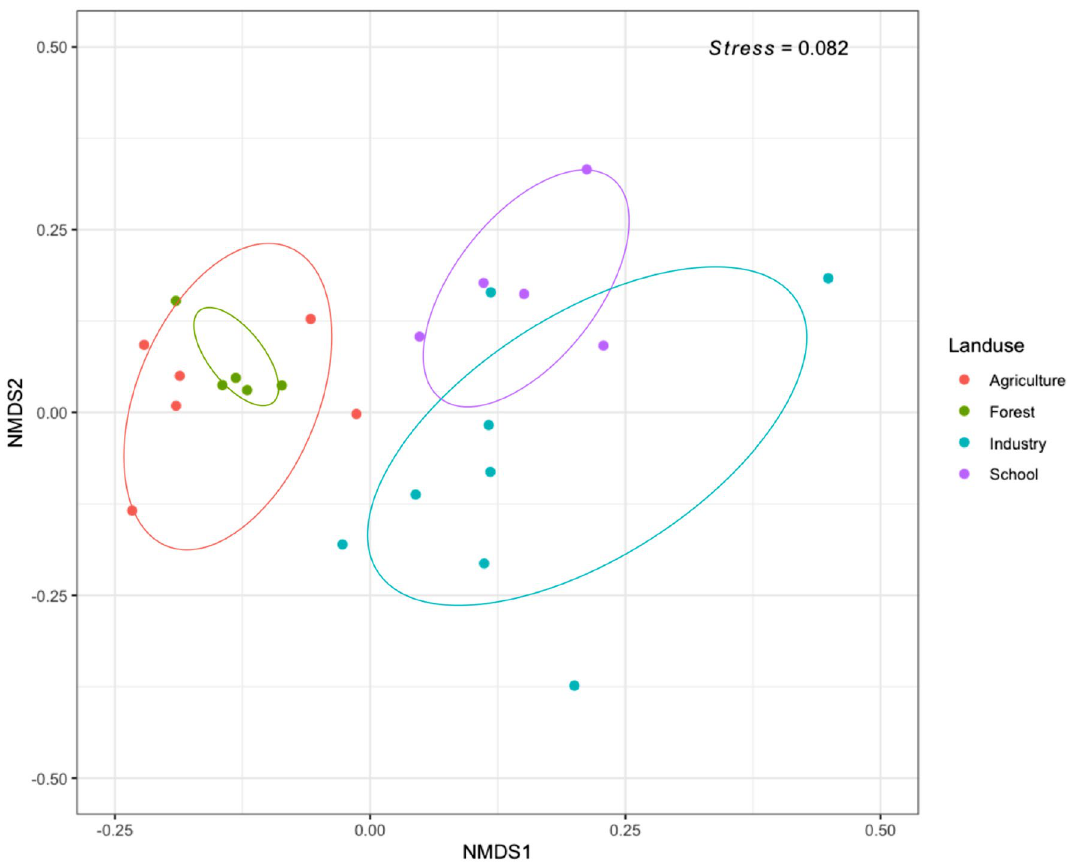
Figure 4. Non metric dimensional scaling plot showing Bray–Curtis distance of 16S rRNA abundance bacterial communities. Distance between the community composition obtained from agricultural (red circles), forested (green circles), industrial and schoolyard (purples circles) sites. The ellipses represent 95% confident